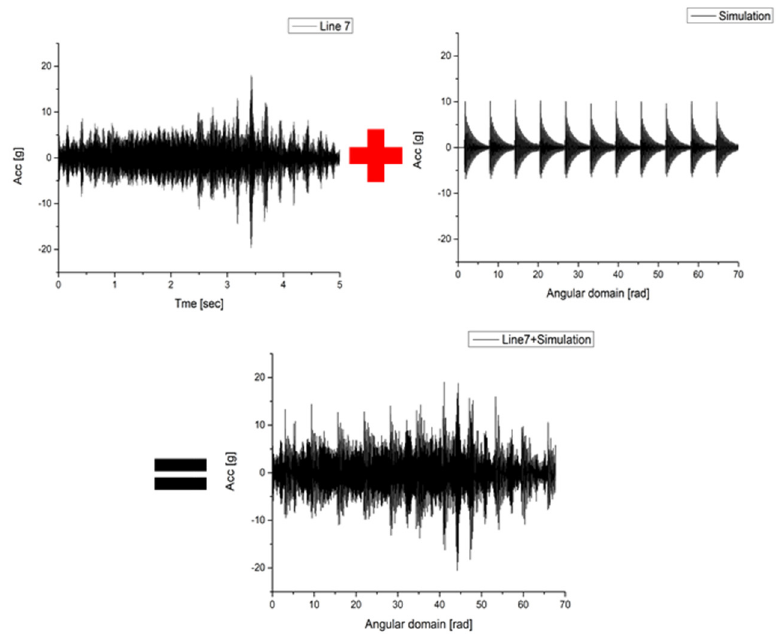
Figure 21. Overlap result (Time domain).